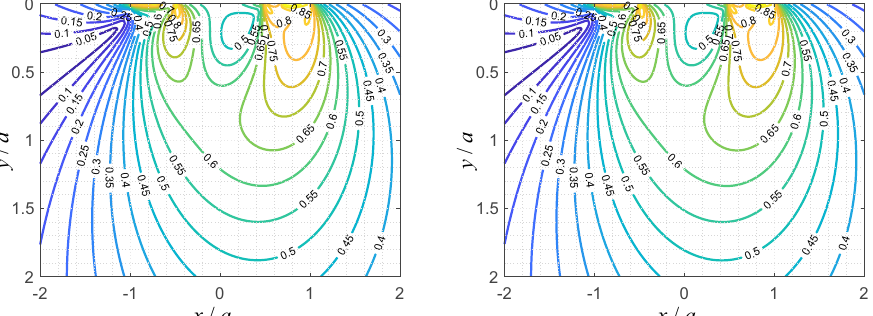
Figure 2. Contour line diagram of the equivalent von-Mises stress, normalized for the average contact pressure P / ( 2 a ) , in the tangential contact with a truncated cylinder, as a function of x / a and y / a , for b = 0.5 a , c = 0.7 a , µ = 0.5 and ν = 0.3; fully analytic solution based on the complex Muskhelishvili potential ( left ) and solution via the numerical superposition of stress fields in the plane Hertzian contact ( right